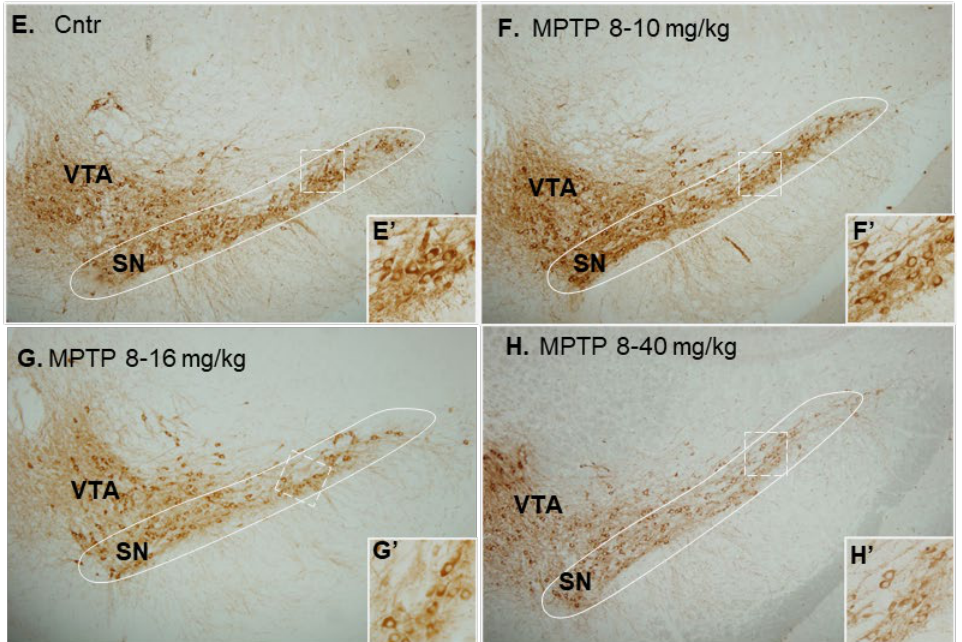
Figure 6. The number of tyrosine hydroxylase (TH)-immunopositive neurons ( A ) and their distribution in the substantia nigra (SN) 24 h after a single injection of 0.9% NaCl (cntr) ( C ) or 1-methyl-4-phenyl-1,2,3,6-tetrahydropyridine (MPTP) at a dose of 40 mg/kg ( D ), as well as the number of TH-immunopositive neurons in the SN 24 h after successive MPTP injections at increasing doses from 8 to 40 mg/kg ( B ) and their distribution after successive MPTP injections at doses from 8 to 10 mg/kg ( F ), from 8 to 16 mg/kg ( G ), and from 8 to 40 mg/kg ( H ), as well as after 0.9% NaCl injections (cntr) ( E ) (“n” per group = 4–6). ( C ’– H ’) is an enlarged fragment (dashed frame) of photographs ( C – H ), respectively * p < 0.05, significant differences compared with the control, taken as 100% (Mann–Whitney U-test). Data are presented as mean ± SEM. Bars: ( C – H )—200 µm; ( C’ – H’ )—50 µm. Cntr—the control group received 0.9% NaCl; VTA—ventral tegmental area.